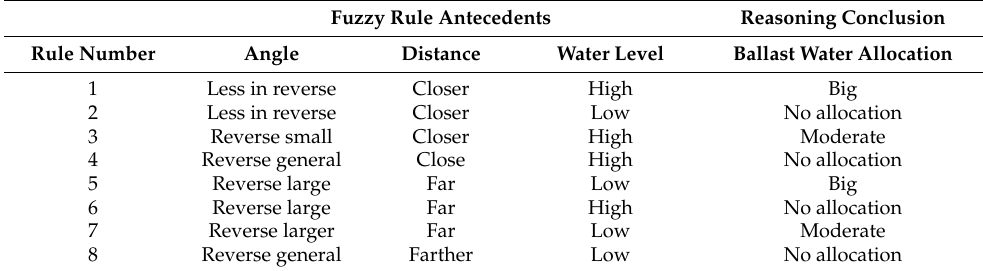
Table 1. Fuzzy rule base for ballast water allocation.